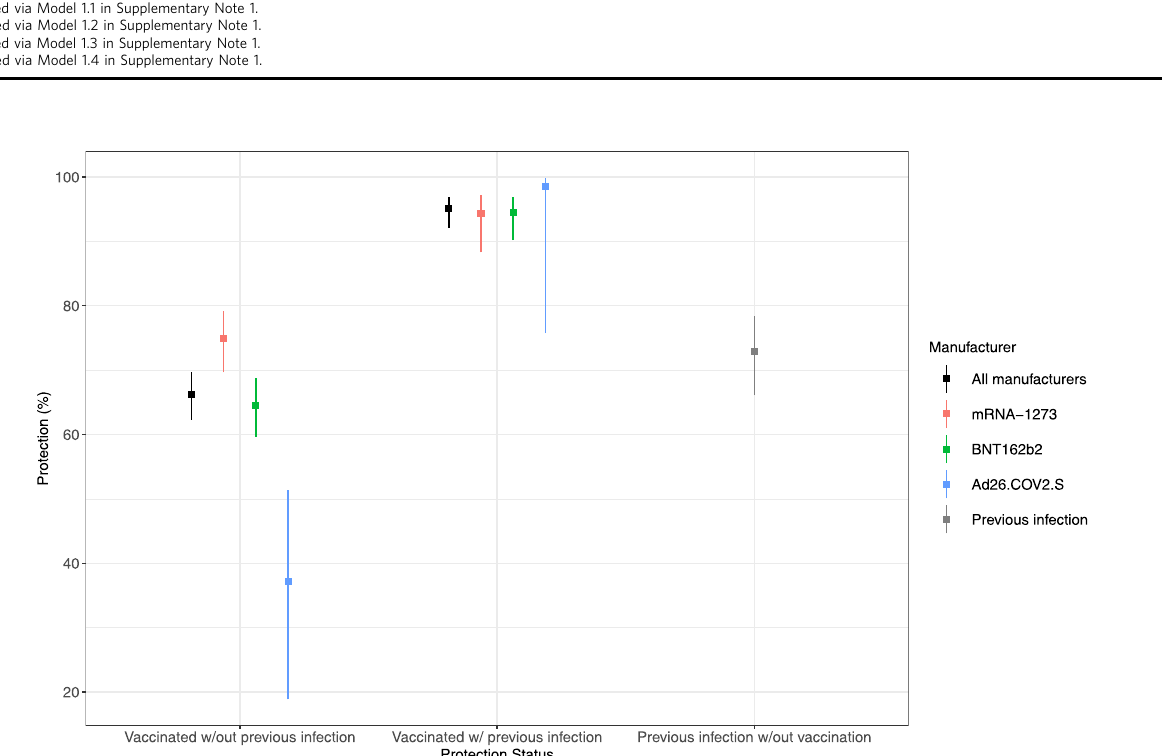
Fig. 1 Estimated protection from vaccination and previous infection. Point estimates (with 95% CIs) of (full) vaccine protection among individuals without a previous SARS-CoV-2 infection, vaccine protection among individuals with a previous SARS-CoV-2 infection, and protection from previous infection only. All estimates of protection are relative to individuals with no protection (unvaccinated without a previous SARS-CoV-2